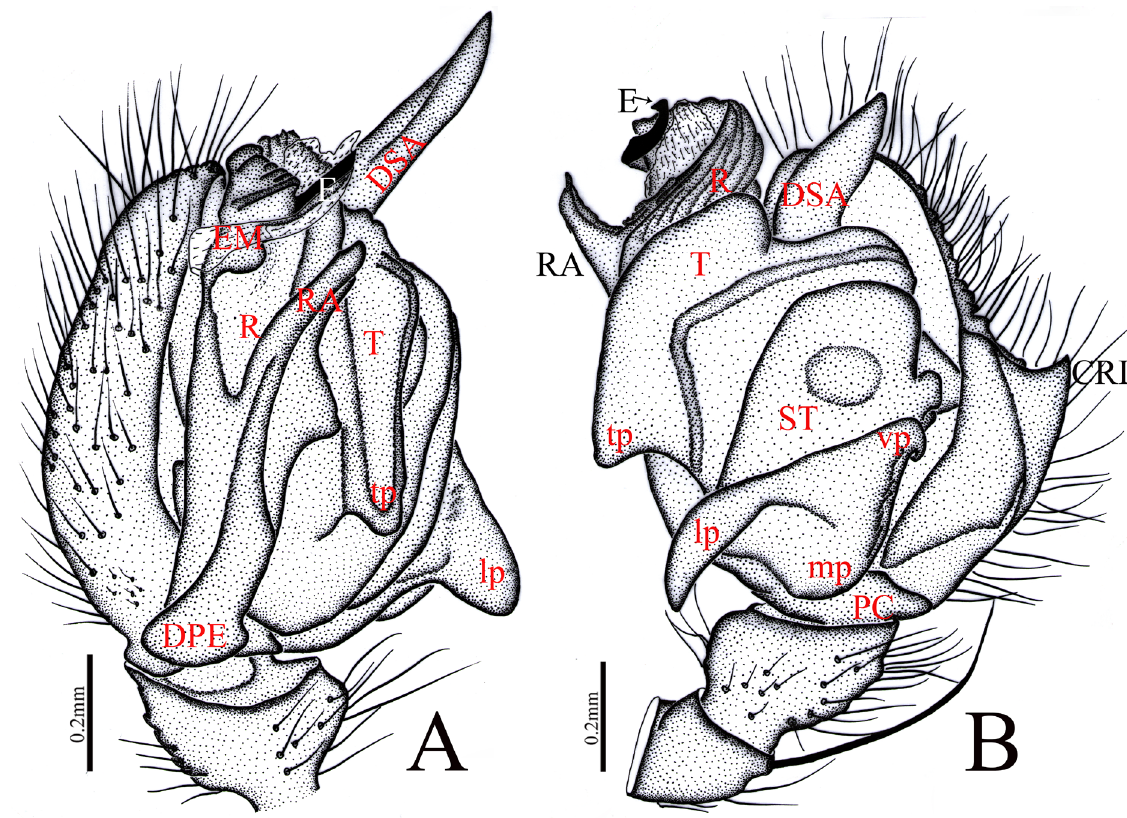
Fig. 31. Acroterius longimultus gen. et sp. nov., ♂, holotype (HNU-20040501–1), palp. A . Prolateral view. B . Retrolateral